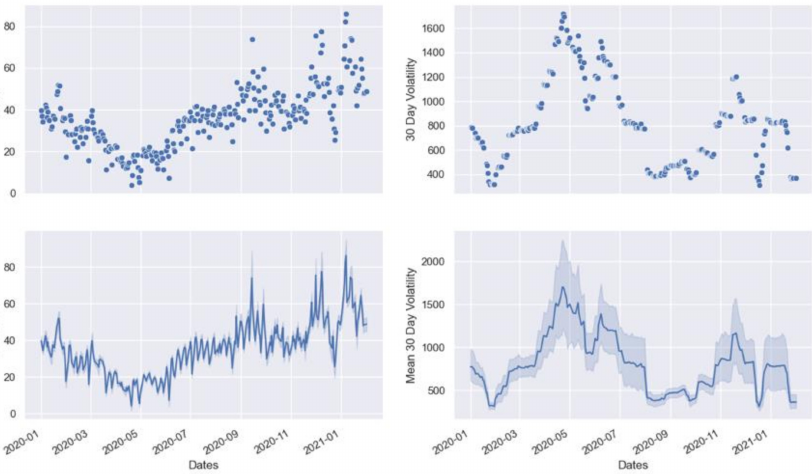
Figure 12. This figure represents the day-ahead price levels for French power including its confidence levels on the left side and the 30-day volatility including its confidence levels on the right side. Figures 7, 8 and 11–14, got generated using the same code in